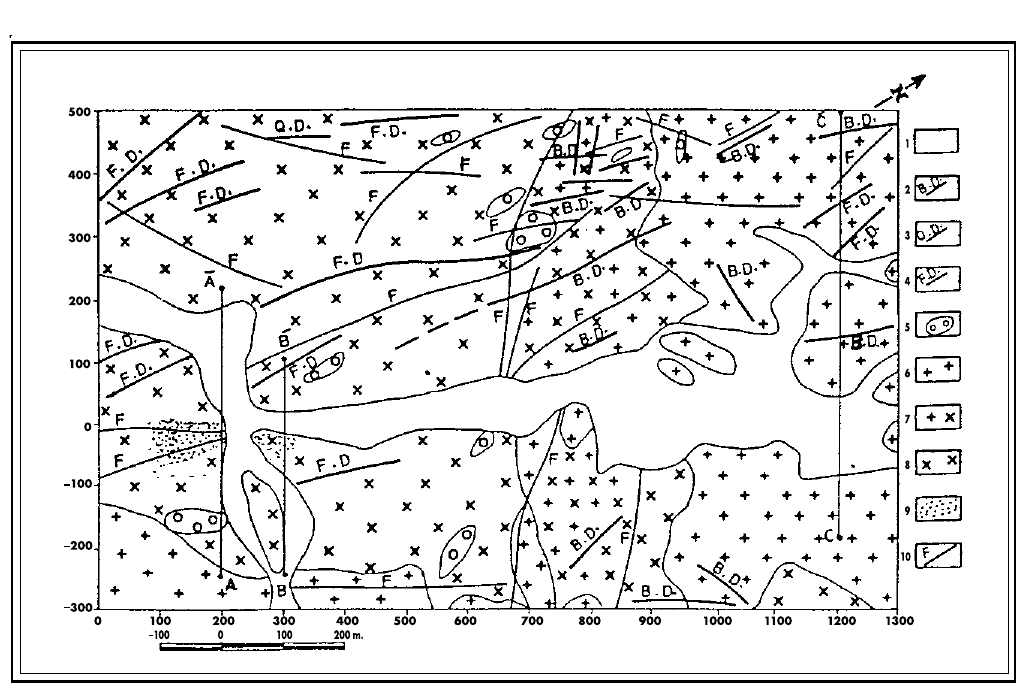
Fig. 2. Detailed geological and structural map of the Abu-Shihat radioactive prospect area, North Eastern Desert, Egypt, showing the 3 lines selected for EM survey. Symbols are: 1 = wadi sediments; 2 = basic dykes; 3 = quartz dykes; 4 = felsite dykes; 5 = pegmatite dykes; 6 = pink granites; 7 = granodiorites; 8 = diorites; 9 = alteration zones, and 10 =